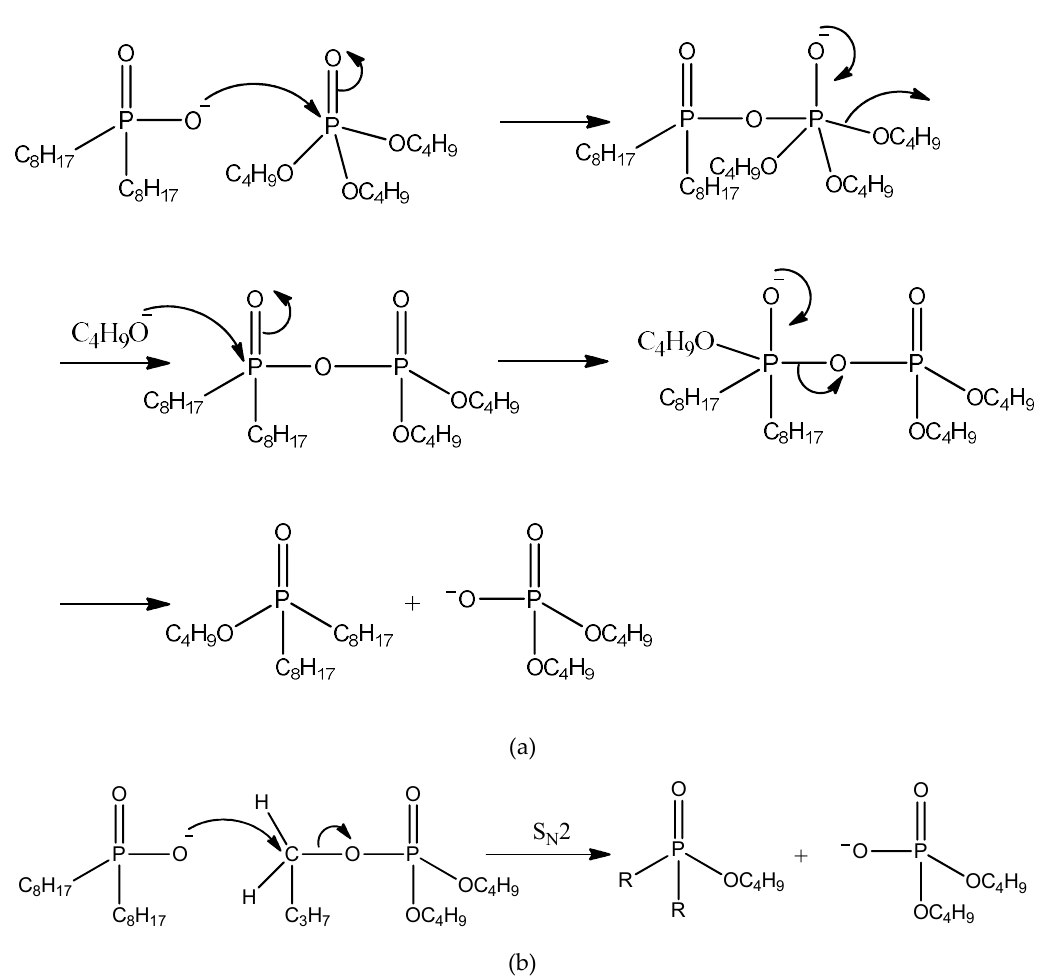
Figure 2. The formation mechanism of butyl phosphinate [23], ( a ) Mechanism 1, ( b ) Mechanism 2. Denote. C8H17 is a 2,4,4-trimethylpentyl Cyanex 301 and Cyanex 302 also react with TBP to form the corresponding butyl esters, and dibutyl phosphate at 65 °C under anhydrous conditions and the rate order is Cyanex 301 > Cyanex 302 > Cyanex 272. Namely, the loss of dithiophosphinic acid in Cyanex 301 is so fast that only 10% remain after six weeks of operation. Besides, some Cyanex 301 also degrades to thiophosphinic (Cyanex 302) and phosphinic acid (Cyanex 272) analogs, which in turn also undergo reactions with TBP. However, there is no information about the mechanism of this degradation in each case.